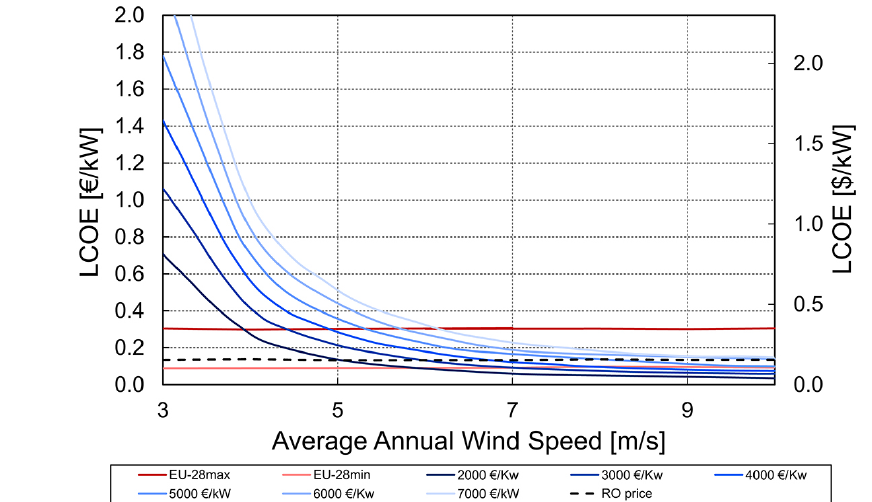
Figure 10. LCOE trends versus annual average wind speed at different specific investment values in EU. Data from Predescu